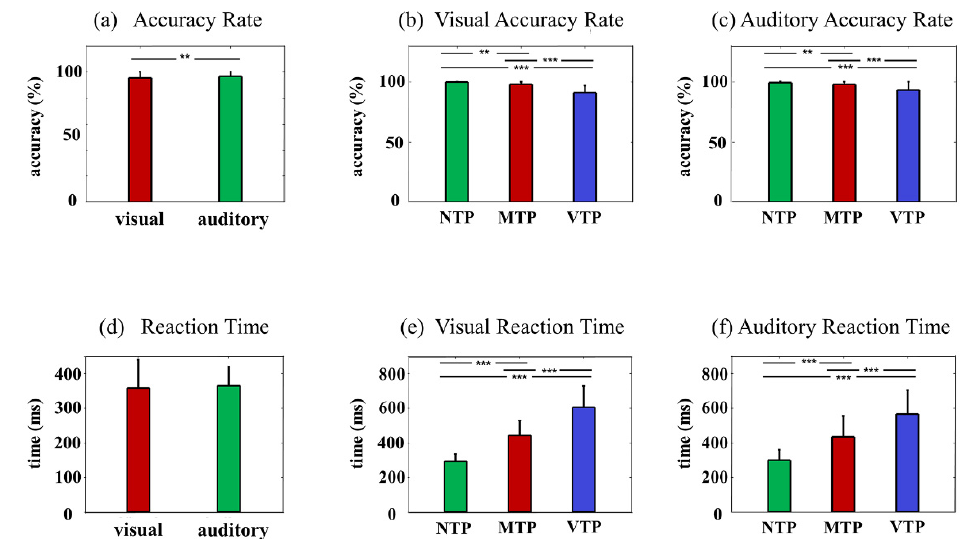
Figure 2. Behavioral results: ( a ) Comparison between reaction times of visual and auditory tasks; ( b ) In the visual and ( c ) auditory modality, the comparisons of reaction time under distinct TP conditions; ( d ) Accuracy comparison between the visual and auditory tasks; and ( e ) In the visual and ( f ) auditory modality, accuracy comparisons under distinct TP conditions. Statistical significance: ** 0.01 < p < 0.1; *** p < 0.001.